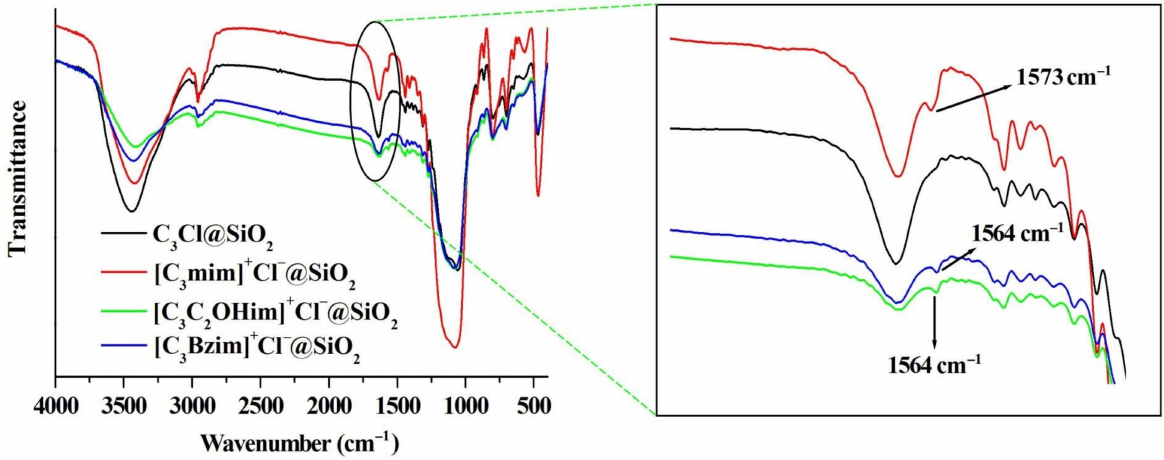
Figure 5. FT-IR spectra of C 3 Cl@SiO 2 , [C 3 mim] + Cl − @SiO 2 , [C 3 C 2 OHim] + Cl − @SiO 2 , and [C 3 Bzim] + Cl − @SiO 2 . The TEM and SEM images of [C 3 mim] + Cl − @SiO 2 are shown in Figure 6 and the TEM and SEM images of [C 3 C 2 OHim] + Cl − @SiO 2 and [C 3 Bzim] + Cl − @SiO 2 are demonstrated in